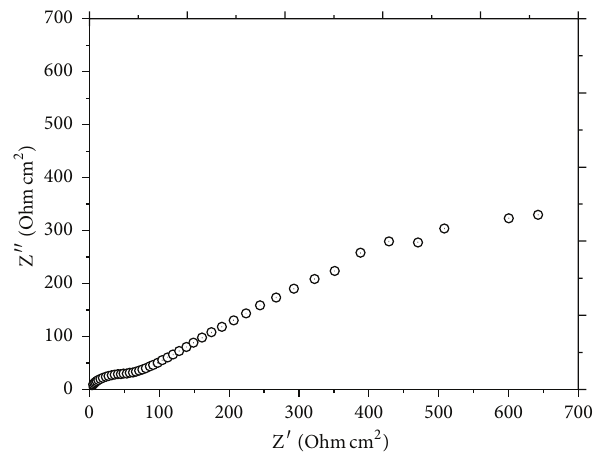
Figure 1: Electrochemical impedance spectroscopy of bare Pt electrode in 1mmol/L Fe ( CN ) 64−/3− solution containing 0.1 mol/L KCl.